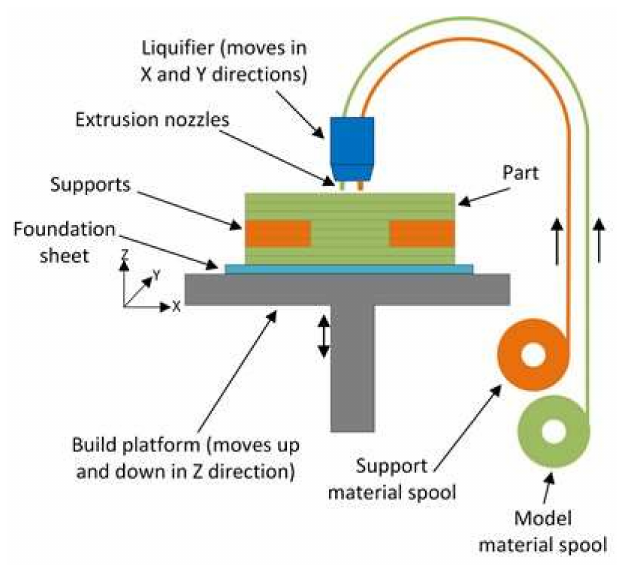
Figure 1. Schematic of fused-deposition modelling (FDM)